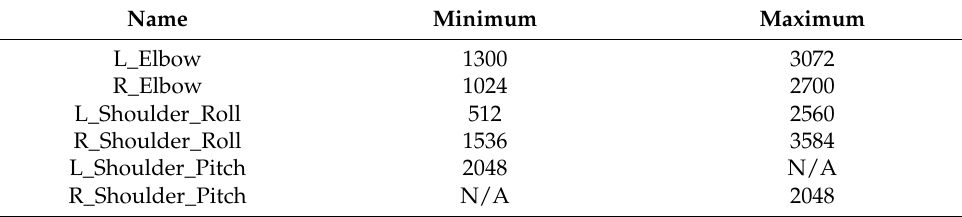
Table 6. Limited rotation range of the humanoid robot motors.